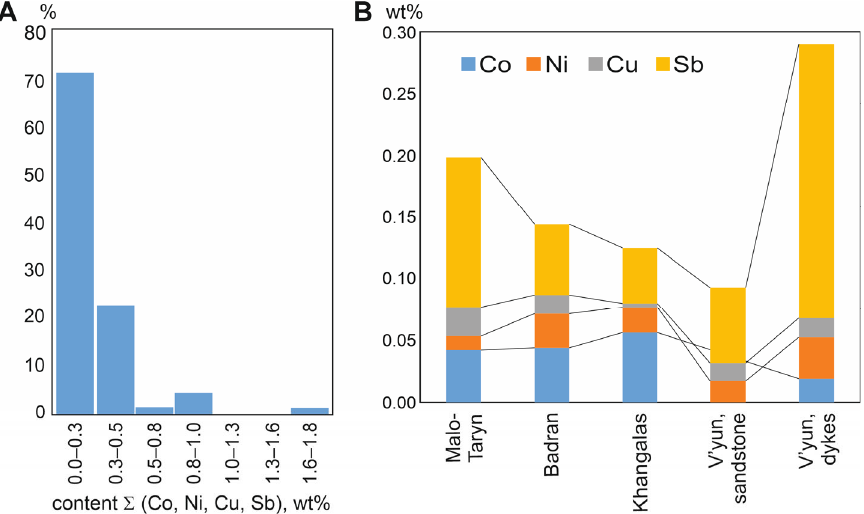
Figure 13. Distribution of trace elements in arsenopyrite1 of the studied OGDs, central YKMB: ( A ) content of Σ (Co, Ni, Cu, Sb); ( B ) the ratio of individual trace elements in the studied deposits.